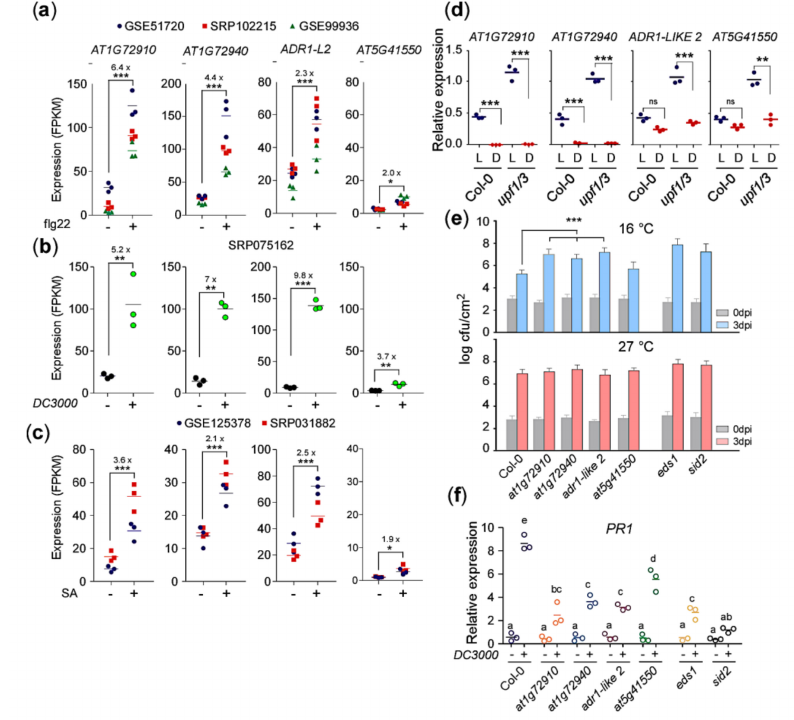
Figure 3. AT1G72910 , AT1G72940 , and ADR1-LIKE 2 are important for plant immunity. ( a ) Expression of group 1 NLR genes in WT plants in response to flg22 treatment, ( b ) bacterial inoculation, and ( c ) exogenous SA treatment. ( d ) Decrease in AT1G72910 , AT1G72940 , and ADR1-LIKE 2 transcript levels in upf1 / 3 mutants by darkness at 16 ◦ C. L: light, D: dark. Increased susceptibility to bacterial pathogen Pst DC3000 ( e ) and decreased PR1 mRNA levels ( f ) seen in at1g72910, at1g72940 , and adr1-like 2 mutants at 16 ◦ C. eds1 and sid2 mutants were used as positive controls. dpi: days post-inoculation. Letters indicate significant di ff erence from one-way ANOVA followed by Tukey’s range tests ( p < 0.05) *: p < 0.05; **: p < 0.01, ***: p ≤ 0.001; ns: not